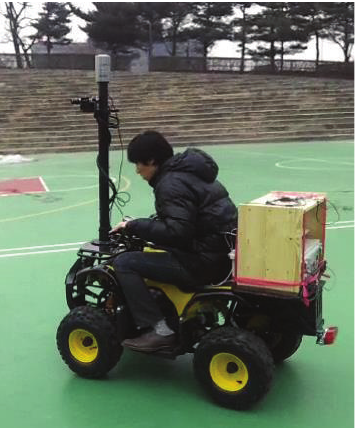
Figure 7: Experimental mobile